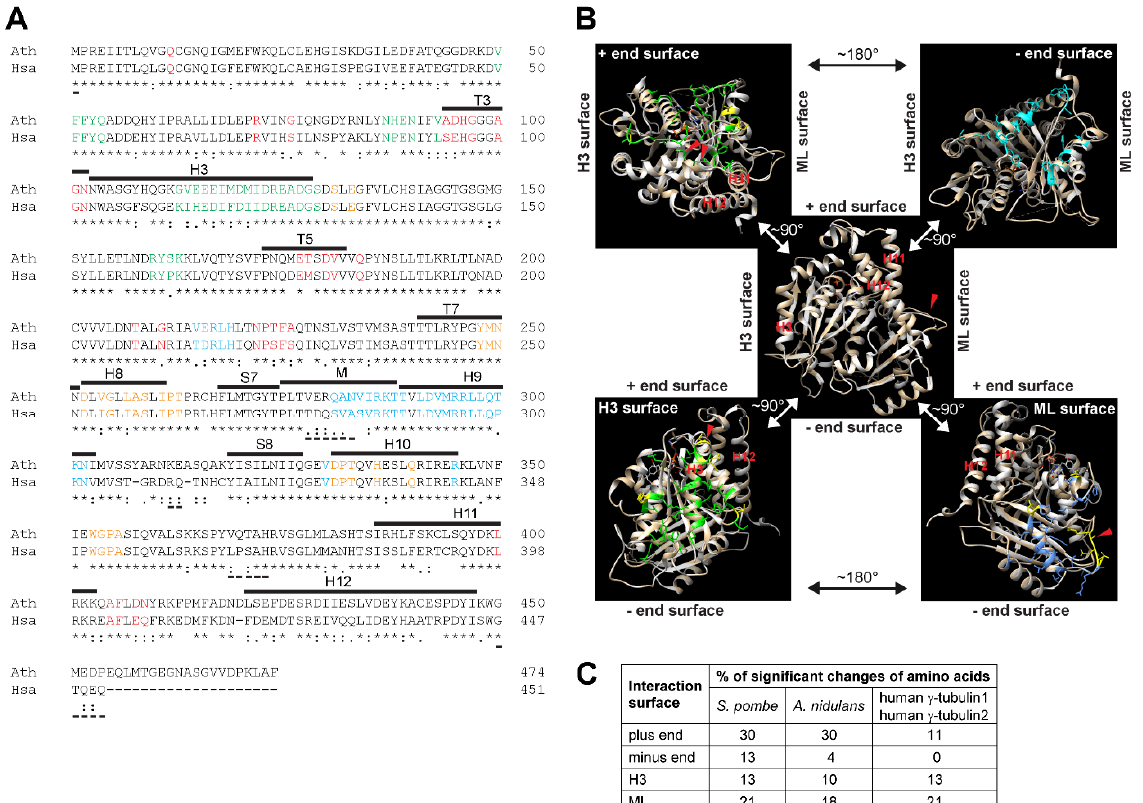
Figure 1. ( A ) The protein sequence alignment of Arabidopsis and human γ -tubulins. Amino acids corresponding to those involved in longitudinal and lateral contacts in α - and β -tubulins are colored: red—plus end surface; orange—minus end surface; green—H3 surface; azure—ML surface. Secondary structures or loops are marked with lines above sequences according to human γ -tubulin PDB ID 3cb2a: H—helix; S— β -sheet; T/M—loop. Identical amino acids are marked under sequences according to ClustalW (T-Coffee) with an asterisk, conserved substitutions of the same size and hydropathy with colon, and semi-conserved substitutions of similar size or hydropathy with dot. Underscore under sequences marks amino acids not visible in PDB ID 3cb2a structure: Ath— γ -tubulin1 from Arabidopsis thaliana ; has— γ -tubulin1 from Homo sapiens . ( B ) Comparison of protein structures of Arabidopsis and human γ -tubulin1. Cartoon representations of a protein structure model of Arabidopsis γ -tubulin1 obtained from a Swiss model (tan) aligned with PDB ID 3cb2a human γ -tubulin1 (white) using Chimera. Amino acids that differed significantly between Arabidopsis and human γ -tubulin1 are marked in yellow (semi-and non-conservative T-Coffee). In the center, there is a marked orientation of plus end and minus end surfaces and H3 and ML surfaces needed for longitudinal and lateral interactions, respectively; helices H11 and H12, H9-S8 loop (red arrowhead). Upper left corner—amino acids involved in longitudinal interactions at a plus end surface (green); changed amino acids are generally smaller and/or less polar than those of human γ -tubulin1; change of HWY motif (red arrowheads); upper right corner—amino acids involved in longitudinal interactions at minus end surface (cyan) includes no significantly different amino acids; bottom left corner—amino acids involved in lateral interactions on H3 surface